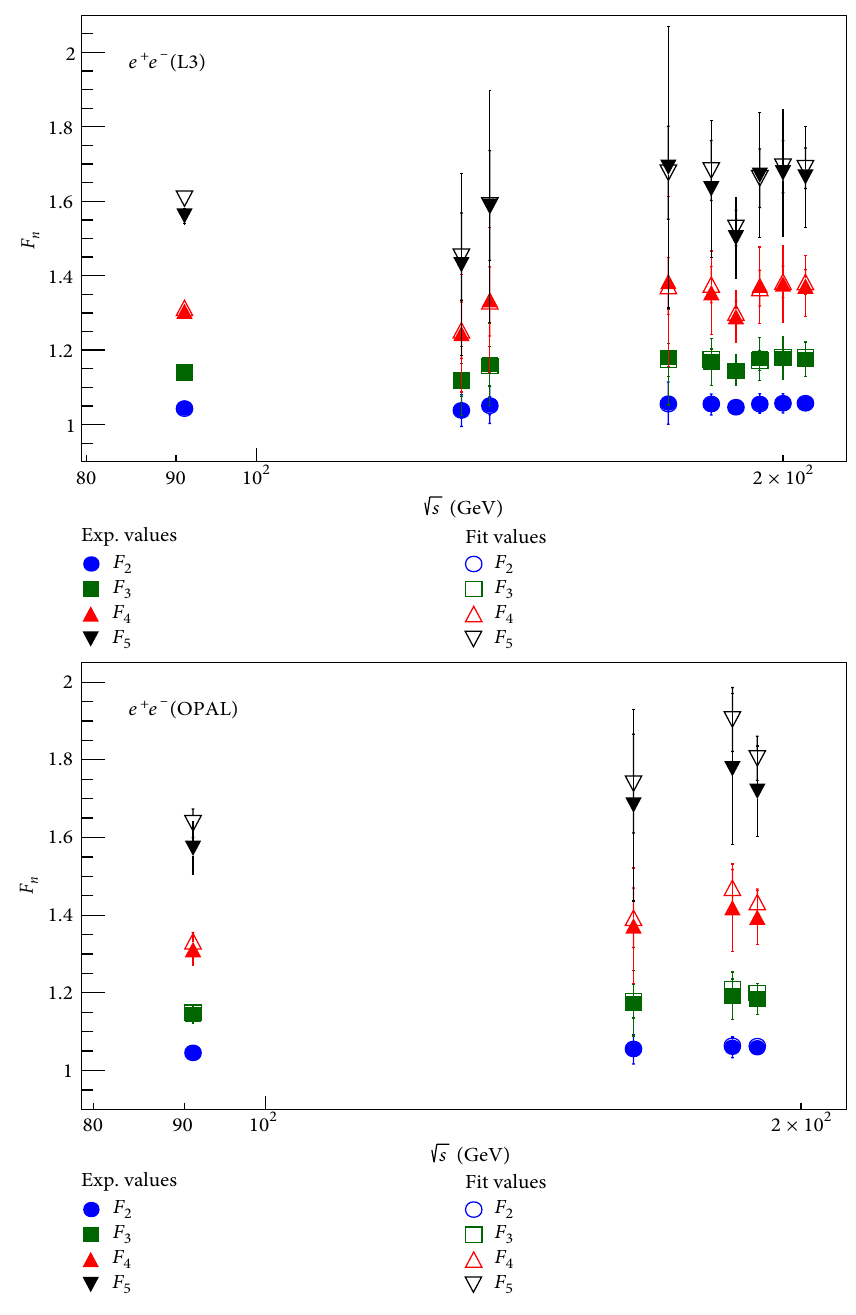
+ − collisions recorded by the L3 and OPAL 𝑒 𝑒